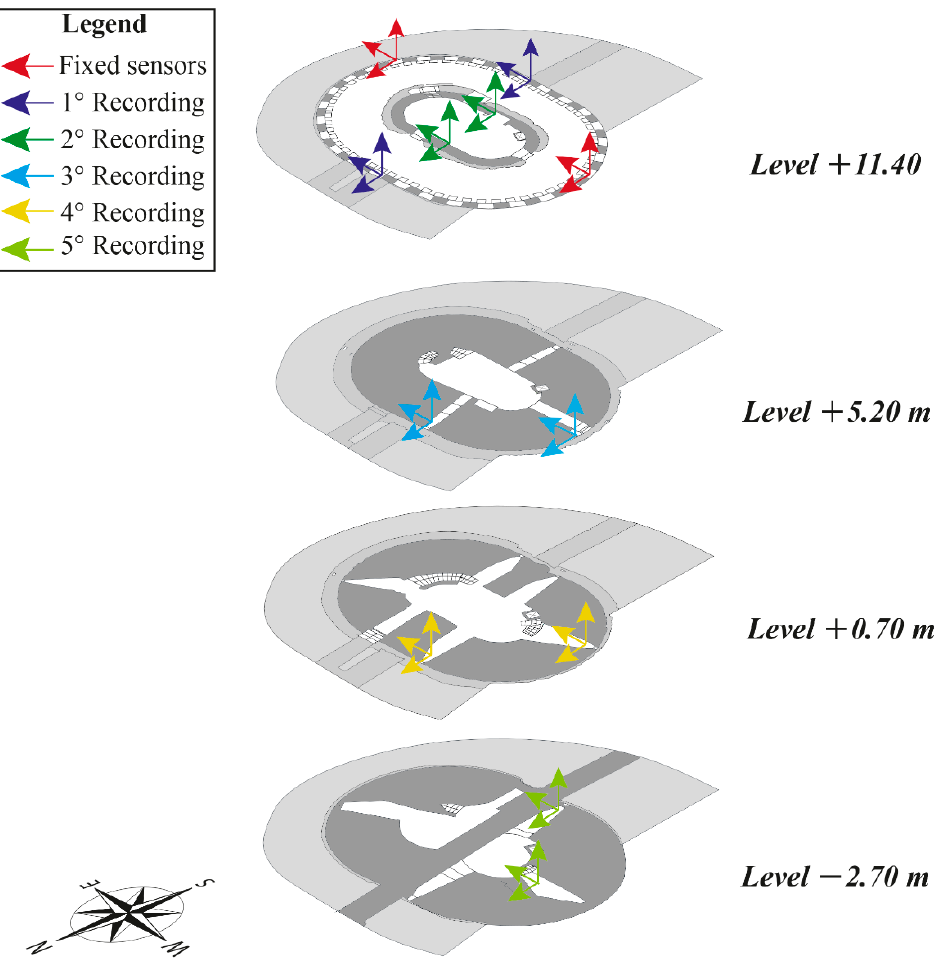
Figure 3. Accelerometers’ set-up used in the Cagli Tower during the ambient vibration tests.